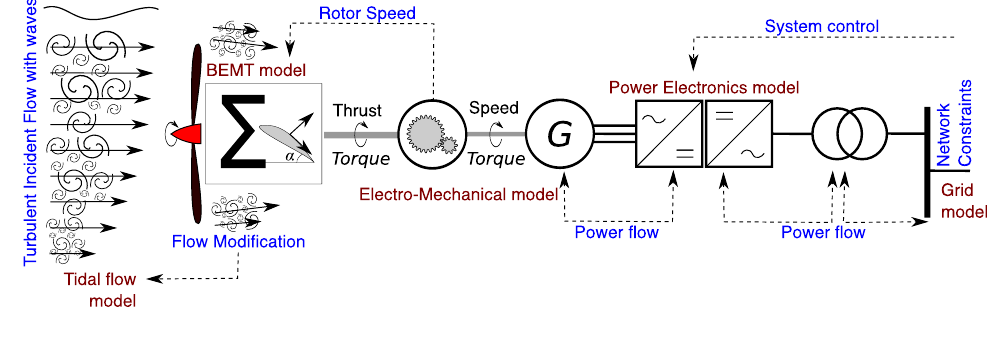
Figure 1. Bi-directional tide-to-wire model of a generalised tidal